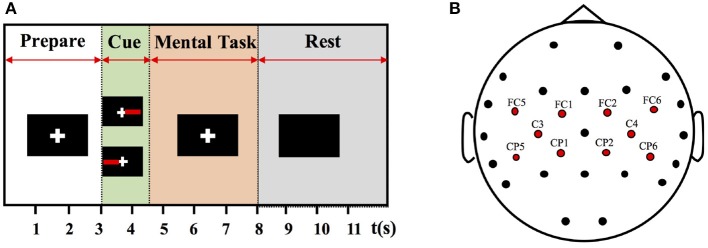
(A) Procedure of a single trial. (B) Distribution of EEG channels. These channels indicated with red dots are selected for further analysis of motor cortical activations.